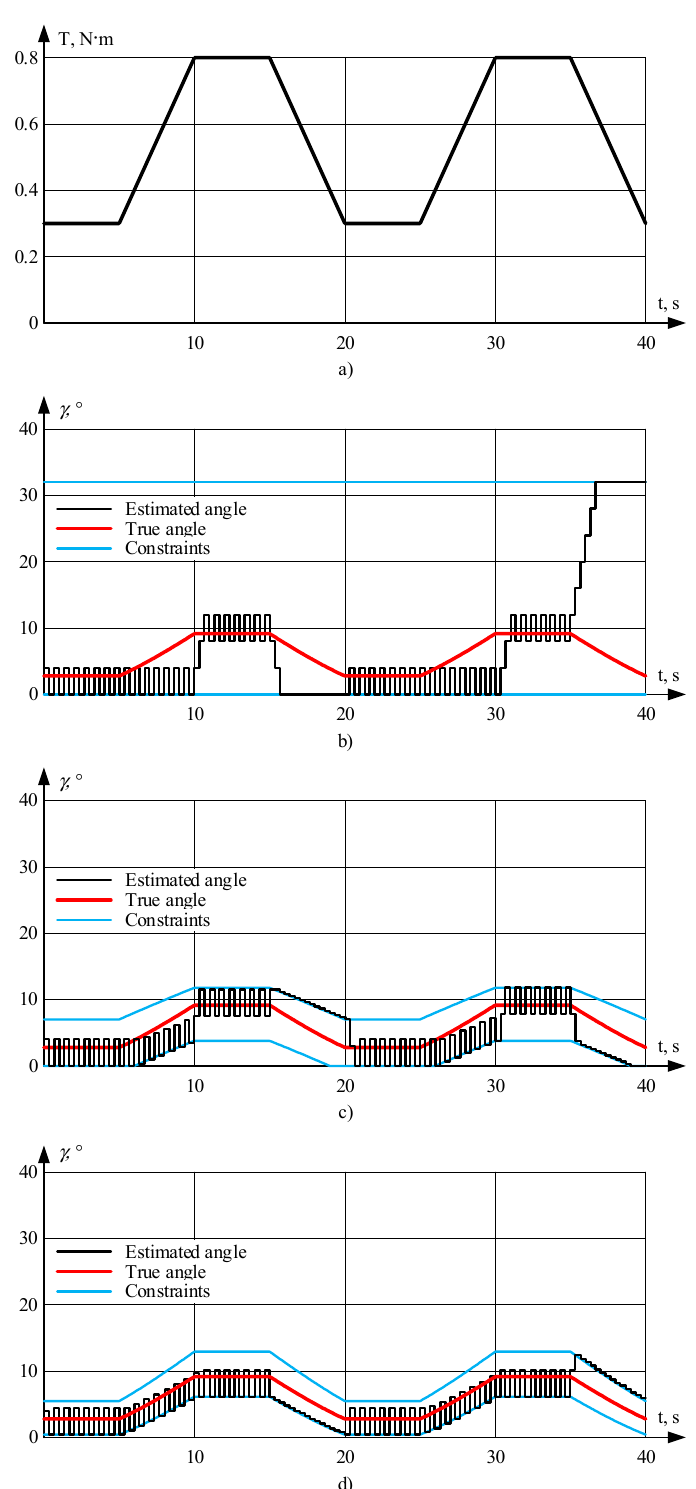
Figure 16. Operation of seeking algorithm with different constraints at low load: ( a ) Torque profile; ( b ) Fixed limits; ( c ) Rated MTPA curve with gaps; and ( d ) Proposed technique.